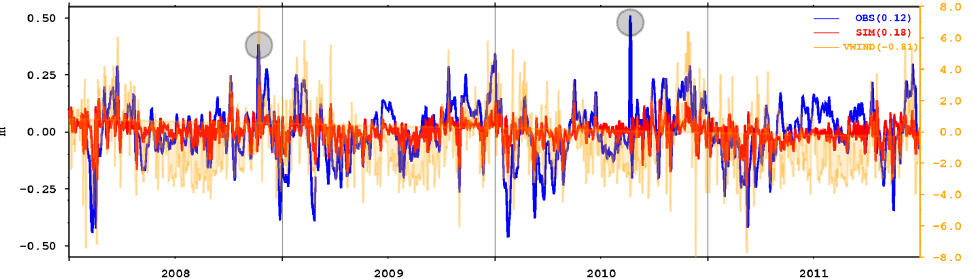
Figure 11. Sea level difference (SLD) between Yalova and ¸Sile and daily averages of the meridional wind speed at B1 (see Fig. 1) between 2008 and 2011. The SLDs in the in situ observation (OBS) and the simulation (SIM) in metres are shown by the blue and red lines, respectively. The meridional wind speed is in orange in metres per second. The 4-year means, which are subtracted from the time series, are shown in the legend. A positive SLD means the sea level is higher in Yalova than in ¸Sile. A positive wind speed means the wind direction is northward. The grey circles mark the Orkoz events on 22 November 2008 and 21 August 2010 as suggested by the observations.